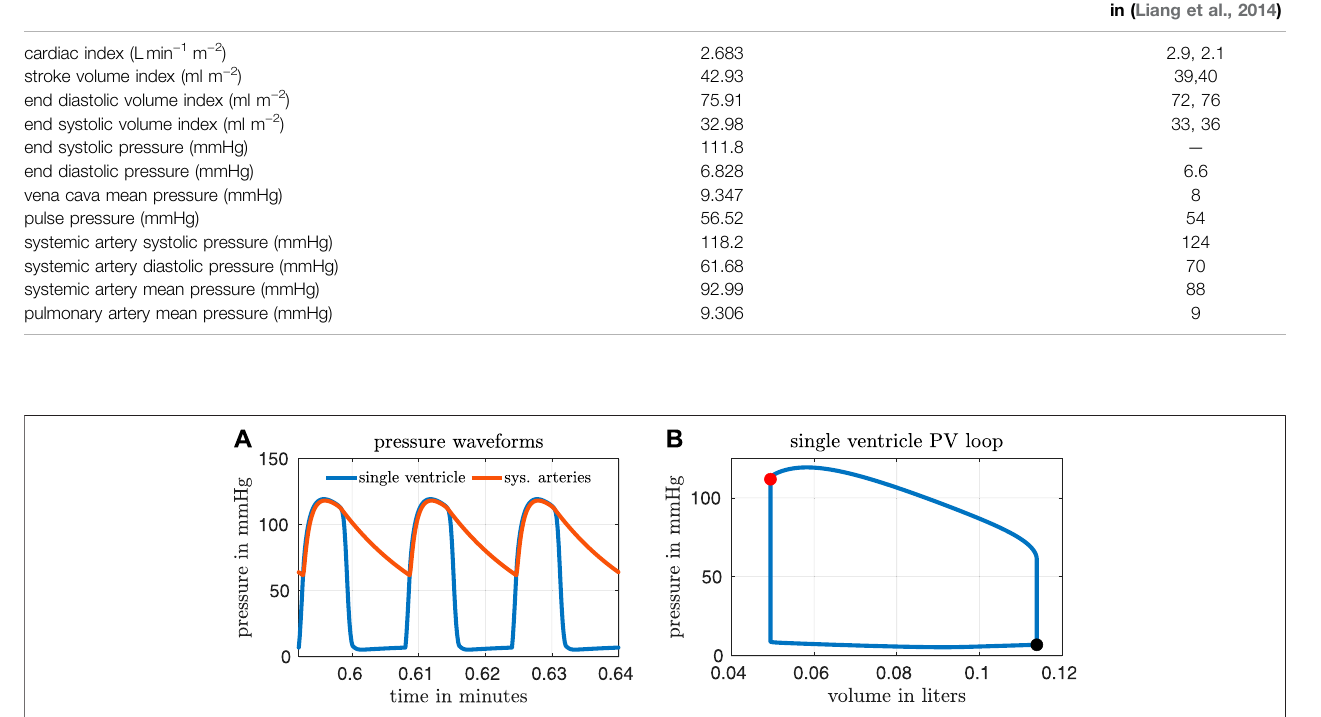
FIGURE 2 | Results from our calibrated model with a closed fenestration. Three pressure waveforms from the end of the simulation are shown in panel (A) and a volumeloopforthesingleventricleisshowninpanel (B) .Theend-systolicandend-diastolicpartsofthepressure-volumeloopareindicatedbytheredandblackmarkers